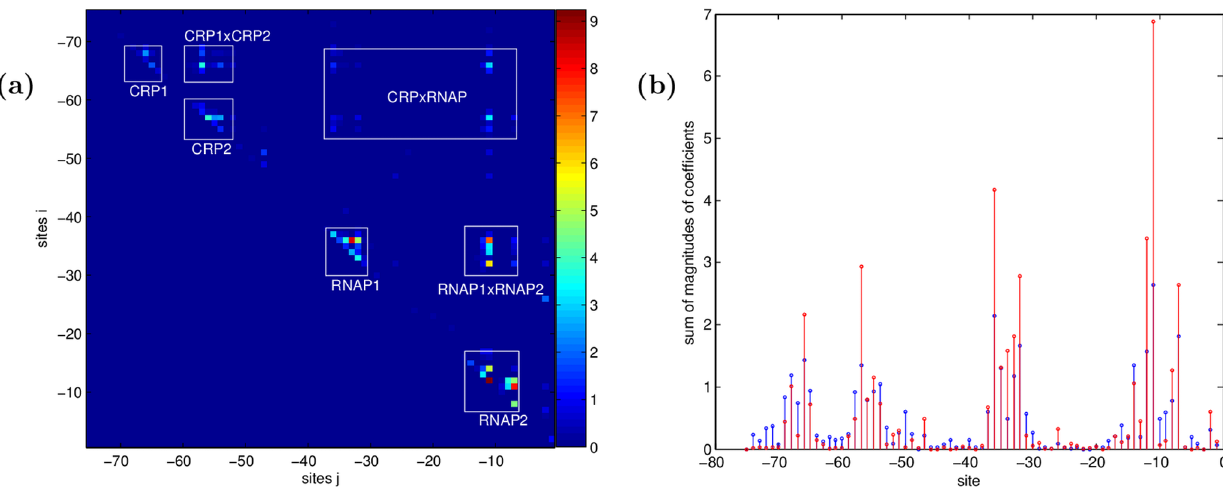
Figure 3. a) Matrix of the sum of the absolute values of the pair interaction coefficients for each pair of sites i , j (3 mutations per site equals 9 interactions) for the chosen statistical model. The clusters near the diagonal are interactions within the RNAP and CRP binding sites, and the off- diagonal clusters are interactions between the binding sites. b) Red: Site-specific sum of absolute values of additive coefficients, divided by 3 (the number of possible mutations). Black: site-specific sum of absolute values of epistatic coefficients, divided by 9 (the number of possible mutation pairs). Epistatic and additive effects are strongly correlated, with the correlation coefficient 0.90.